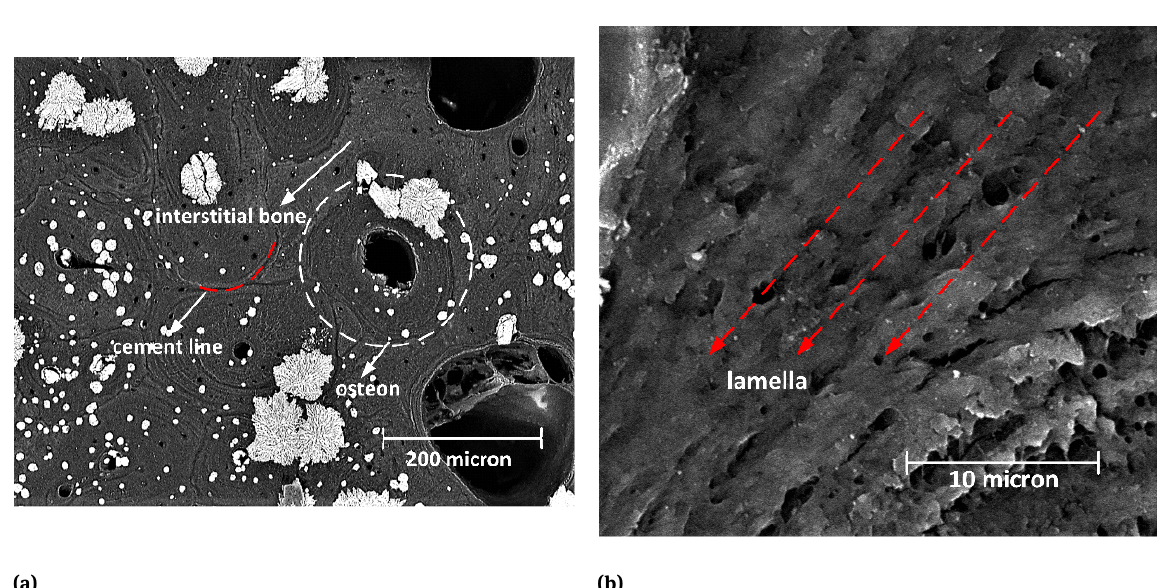
Figure 2: The SEM images of the middle region of unloaded cortical bone. ( a ) The white dotted circle shows an osteon, the red dotted line covers part of the cement line, and the irregular interstitial bone distributes between the osteon indicated by a white arrow; ( b ) The red dotted arrows show the orientation of three adjacent Haversian